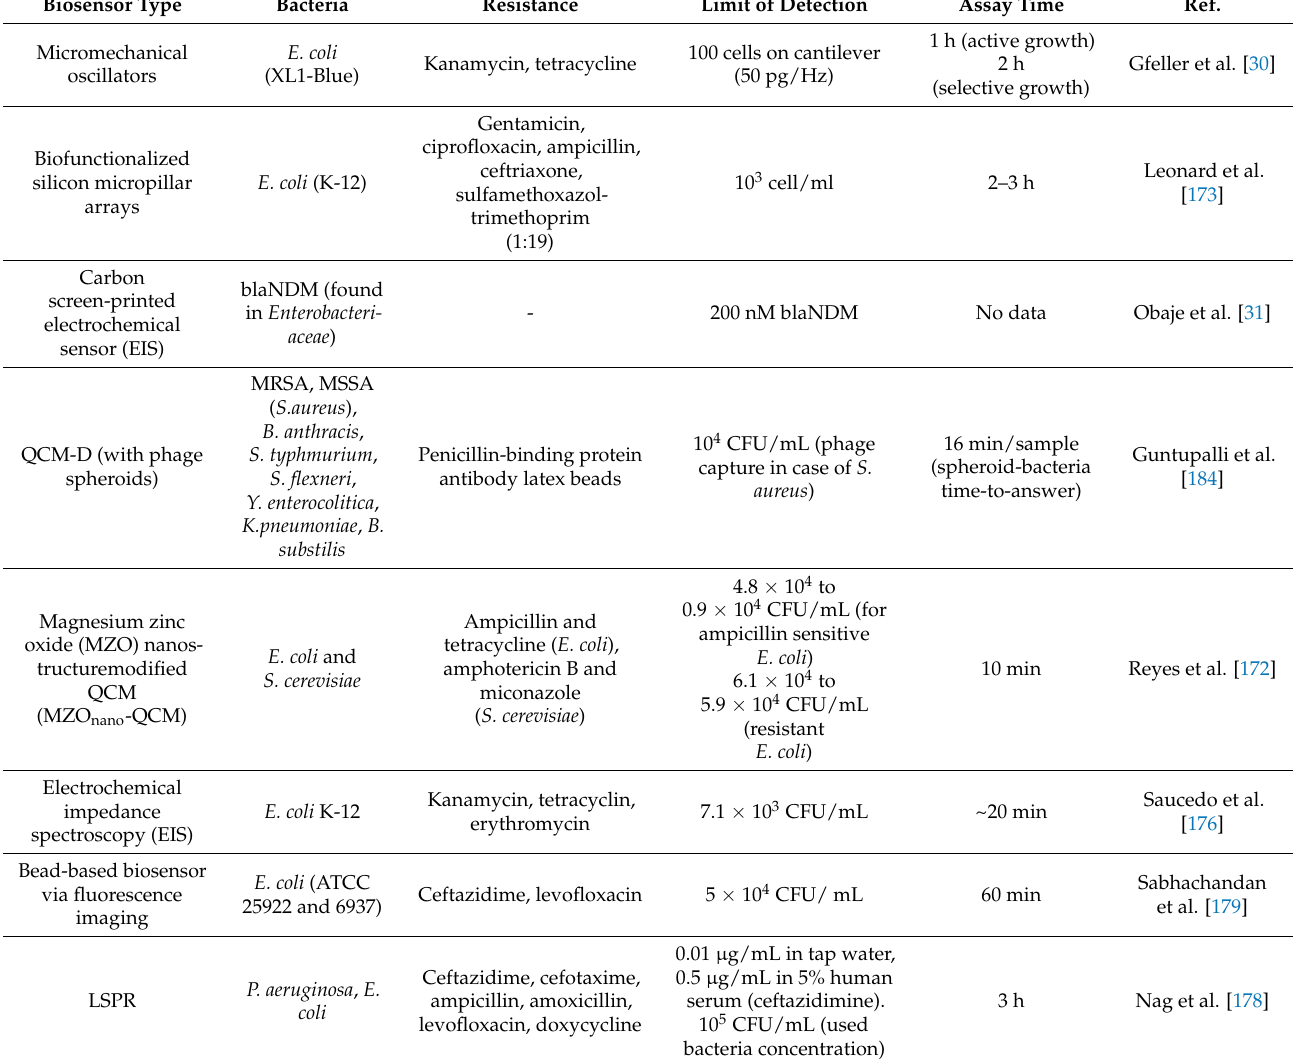
Table 2. Summary of biosensors reported as capable of detecting antibiotic